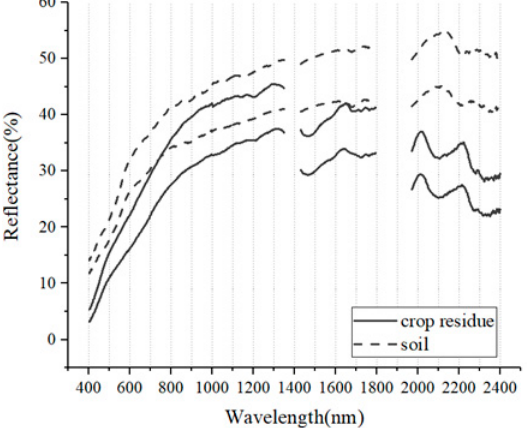
Figure 9. The spectral curve of winter wheat residues and soil.